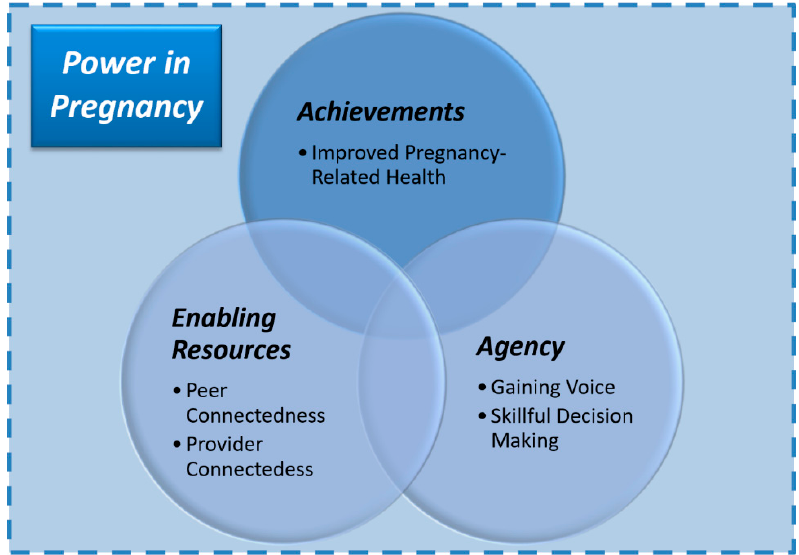
Figure 1. Women’s empowerment, sources of anxiety, and coping strategies in pregnancy: conceptual framework adapted from Kabeer’s (1991) model for women’s empowerment and Klima et al. (2015) constructs for pregnancy-related empowerment to understand the sociocultural experience of maternal prenatal anxiety as it relates to maternal decision-making and social support in the South Asian context.